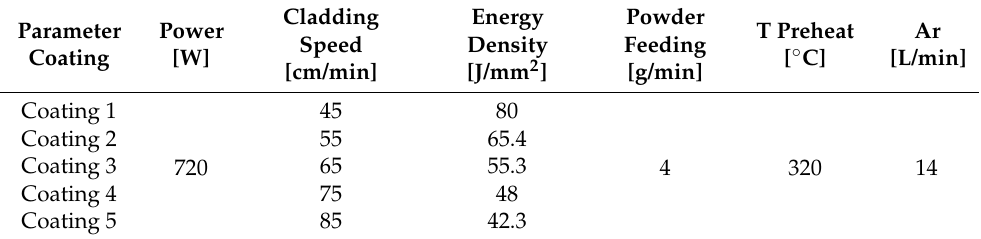
Table 4. Laser cladding